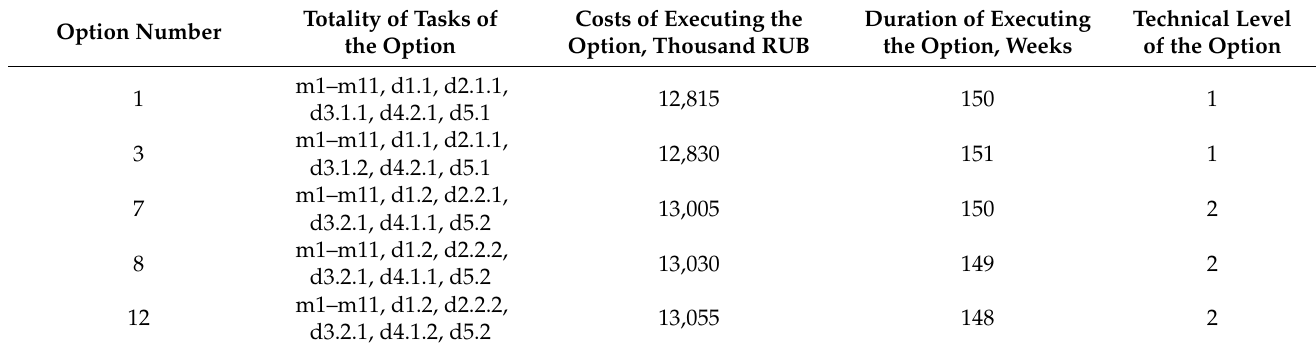
Table 8 contains the specifications of the chosen options. Table 8. The specifications of the set of effective project options.